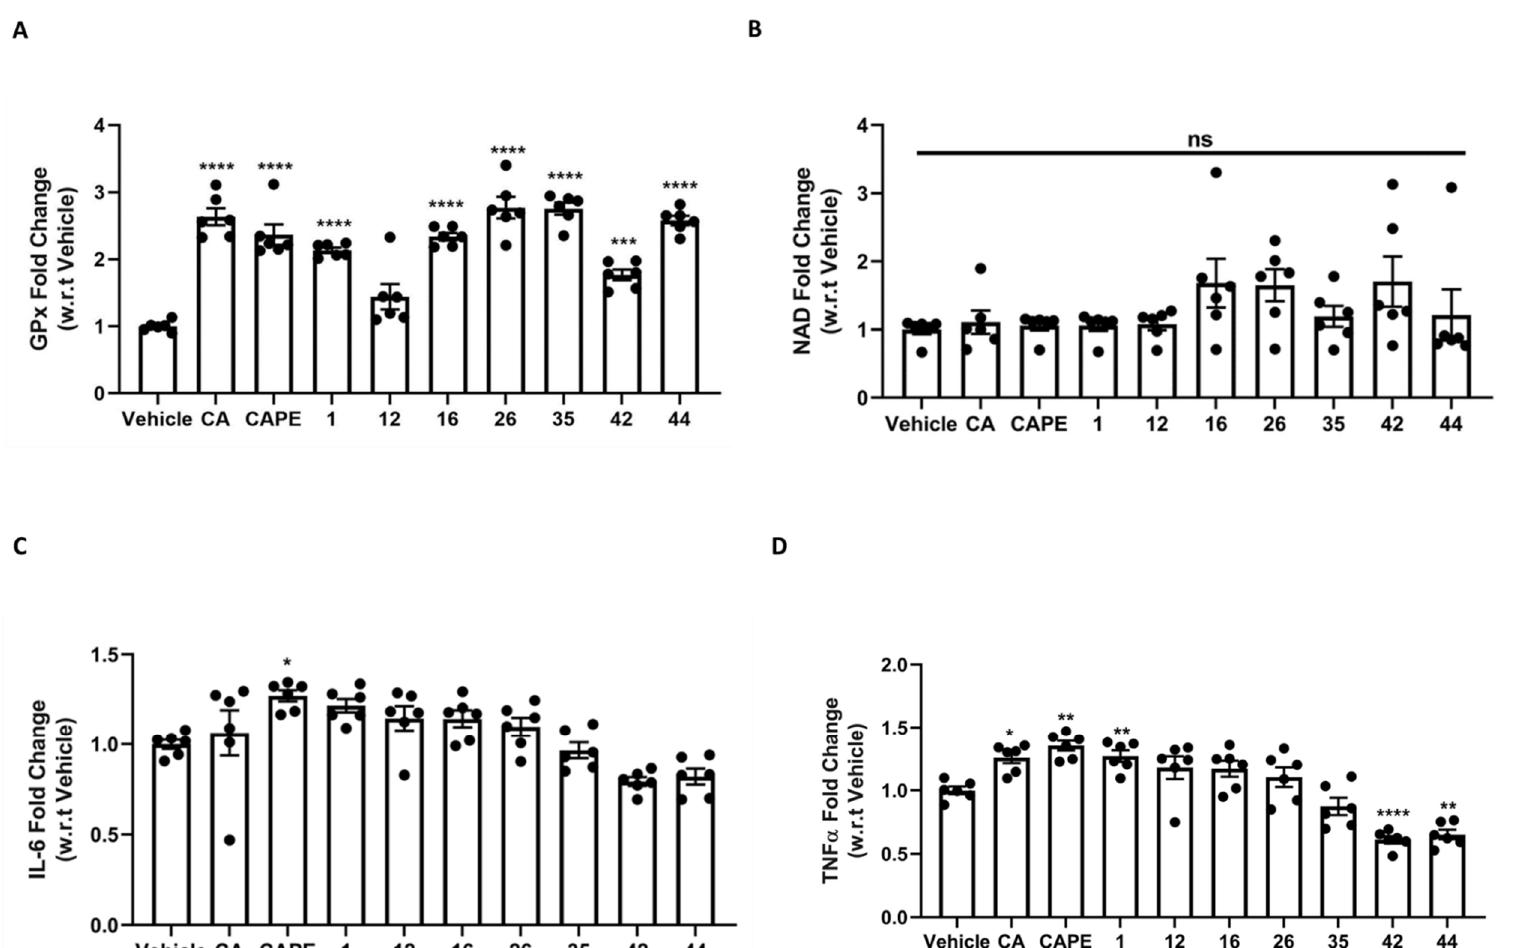
Figure 4. The impact of Caffeic acid and CAPE analogs on various antioxidant parameters. The 293T cells were pre-treated with 10 µ M of the selected compounds for 24 h and then the selected biomarkers were observed using ELISA: ( A ) GPx ( B ) NAD ( C ) IL-6 and ( D ) TNF α were analyzed. Ordinary one-way analysis of variance (ANOVA) was performed followed by Dunnett’s multiple comparisons test to identify statistical difference * p < 0.05, ** p < 0.01 *** p < 0.001, **** p < 0.0001, ns: non-significant.